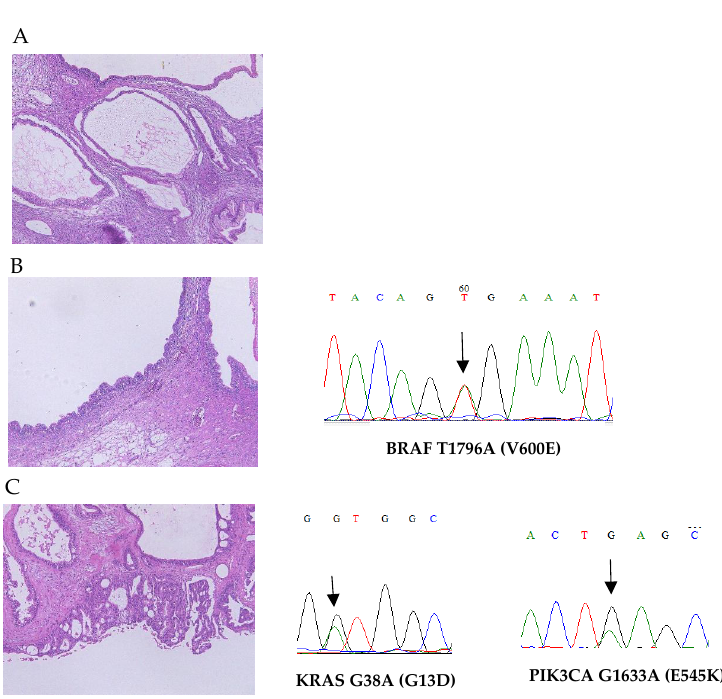
Figure 1. Heterogenous mutation pattern within a tumor according to heterogenous tumor histology (Case 1). ( A ) Mucinous cystadenoma showing no mutation. ( B ) Mucinous borderline tumor showing V600E mutation (1796 T > A) in BRAF. ( C ) Mucinous ovarian carcinoma showing E545K mutation (1633 G > A) in PIK3CA and G13D mutation (38 G > A) in KRAS.